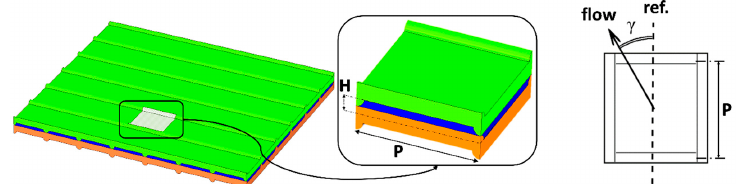
Figure 1. Profiled membranes of the Overlapped Crossed Filaments (OCF) type. The repetitive periodic unit of a cell pair is shown, enlarged, in the inset. The geometric parameters H (channel thickness), P (pitch) and γ (flow attack angle) are indicated.